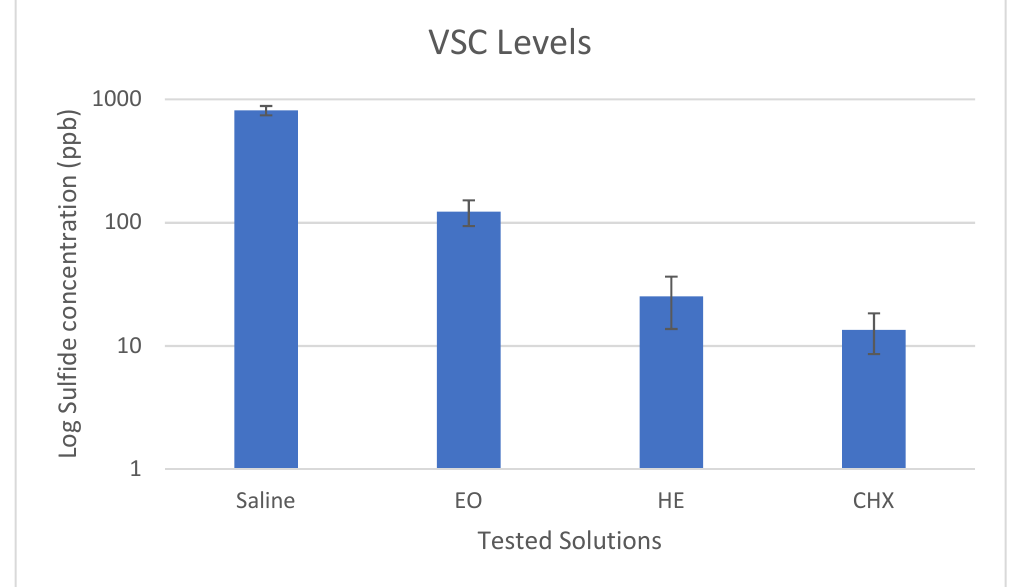
Figure 2. The mean results (±SD) of the Volatile Sulfide Compounds (VSC) levels measured using a sulfide monitor (Halimeter), for the various tested solutions: Saline, essential oils (EO), herbal extracts (HE), and chlorhexidine (CHX) formulations as indicated.